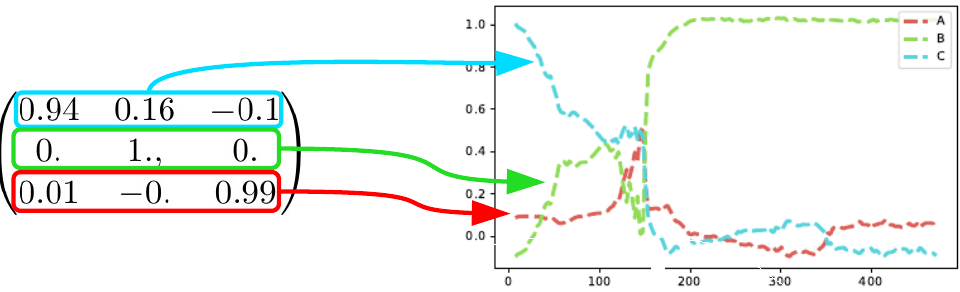
Figure 11. Each row in the transition probability matrix K ( τ ) represents the trend of a chemical